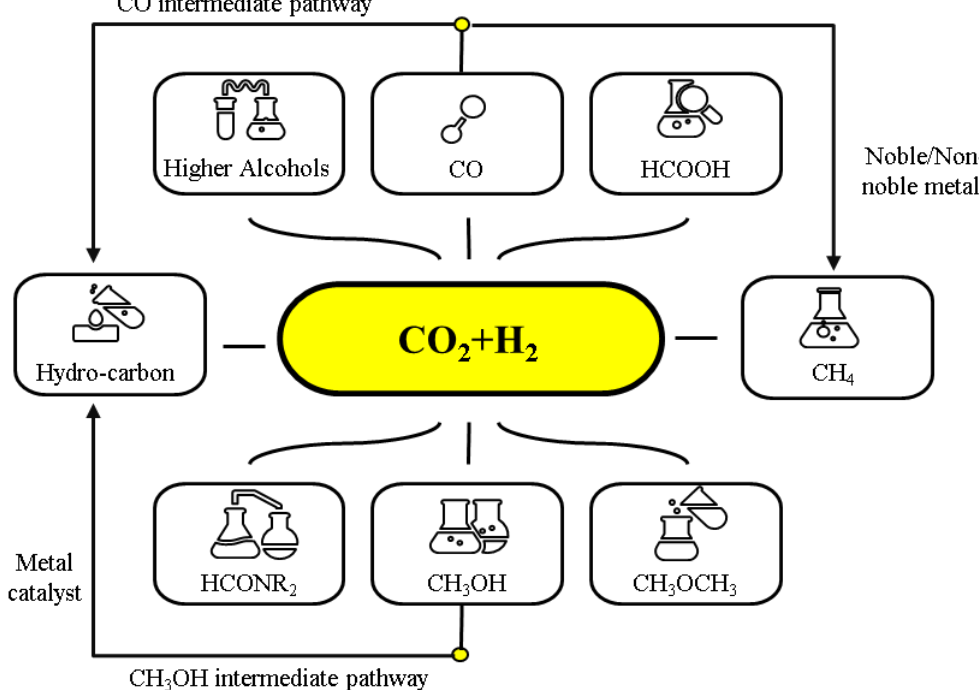
Figure 1. CO 2 to be hydrogenated to produce chemical compounds and